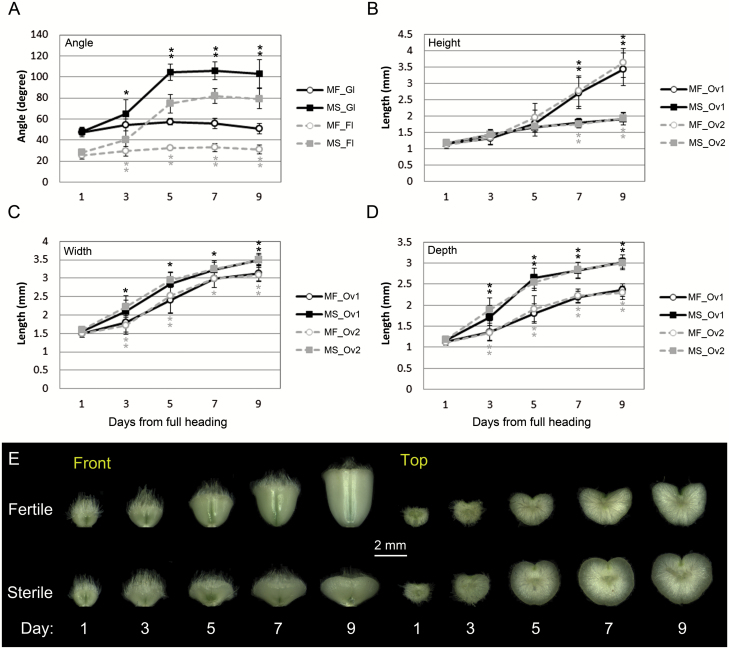
Measurements of flower opening angle and ovary size. (A) Glume angle (suffix, _Gl) and floret angle (suffix, _Fl), defined in Supplementary Fig. S1B, were measured at different flowering stages (1–9 d from full heading). Spikelets of male-fertile (prefix, MF) and male-sterile (prefix, MS) plants were used for the measurements. (B–D) Ovary height, width, and depth, defined in Supplementary Fig. S1C, were measured at different flowering stages. Ovaries from primary florets (suffix, _Ov1) and secondary florets (suffix, _Ov2) of male-fertile and male-sterile plants were used for the measurements. Significant differences between male-fertile and male-sterile plants for corresponding samples (indicated by black solid or grey dotted lines) at the same stage are indicated in the graphs (ANOVA test significant P-value: *P<0.01; **P<0.001). Error bars=SD. (E) Images of ovary/caryopsis during flowering and early grain development. Front and top images were taken as described in the text.